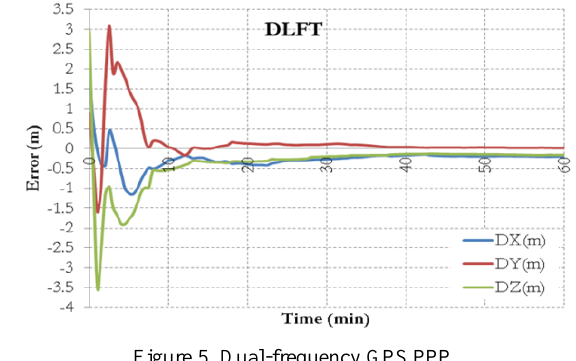
Figure 5. Dual-frequency GPS PPP